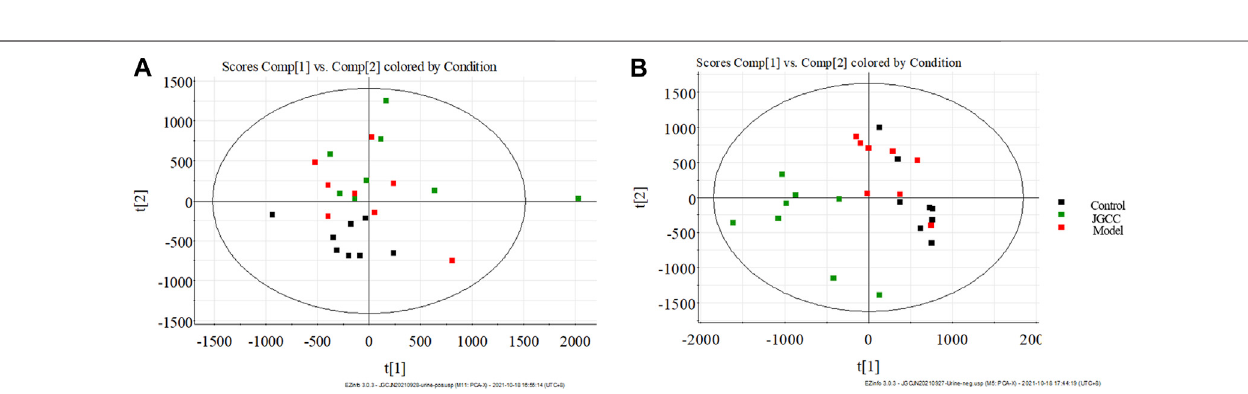
Frontiers in Pharmacology |